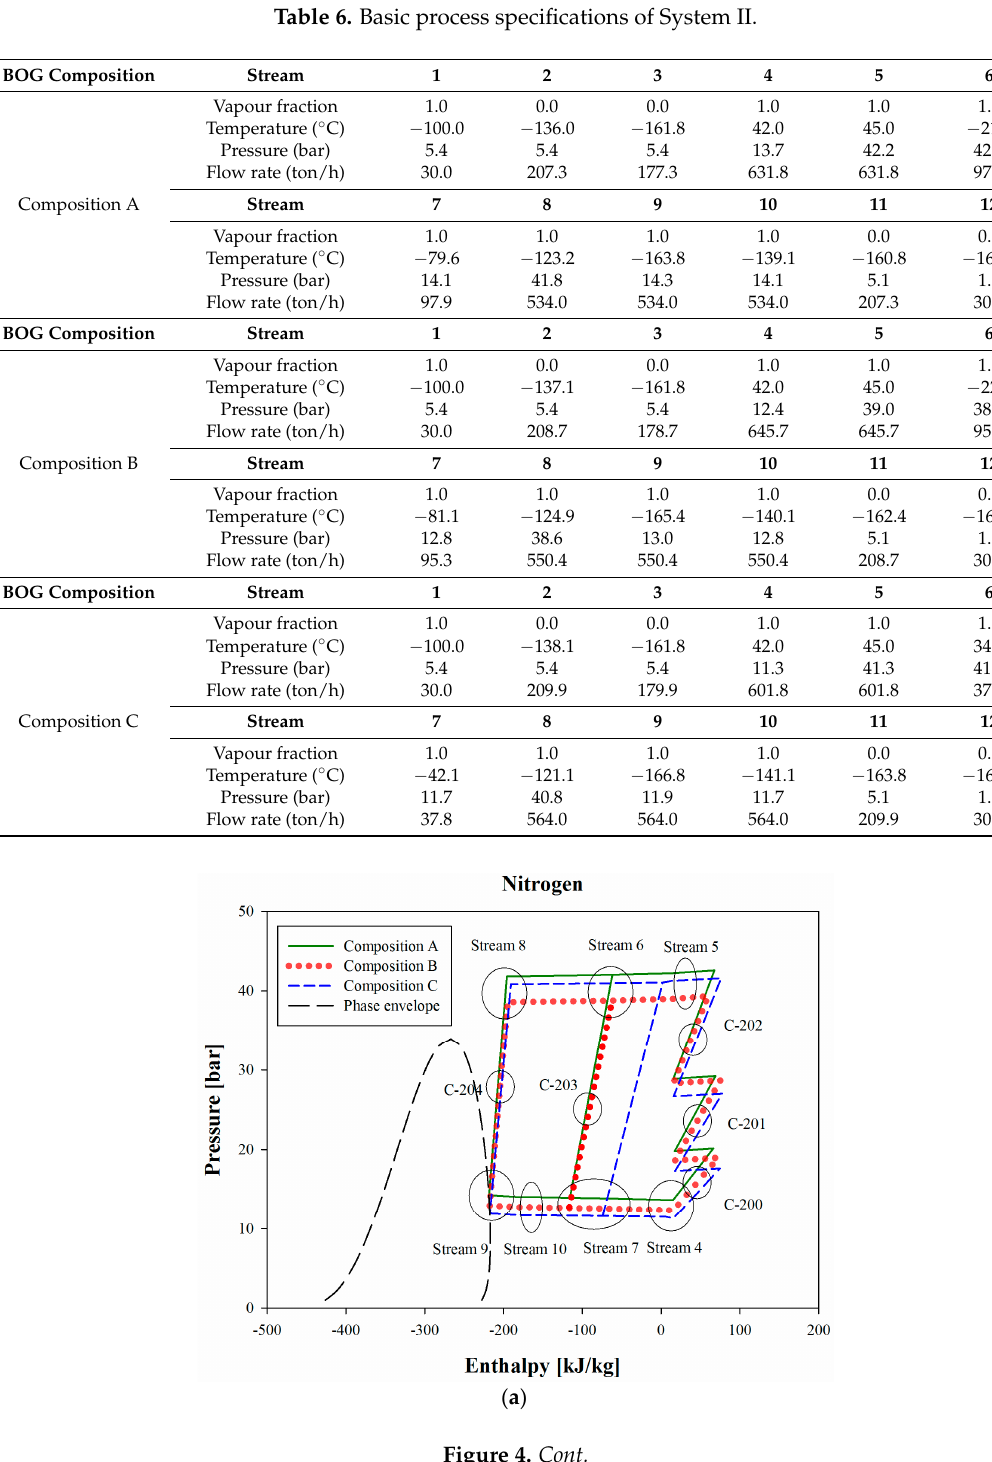
Table 6. Basic process specifications of System II.